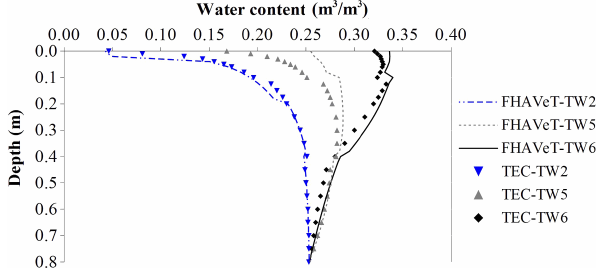
Figure 8. Water content profiles in TW 2 (dry conditions, Avi- gnon climate, DOY (day of year) 275), TW 5 (dry conditions, Mons climate, DOY 292) and TW 6 (wet conditions, Mons climate, DOY 300) for soil AL-SiL, Wosten pedotransfer